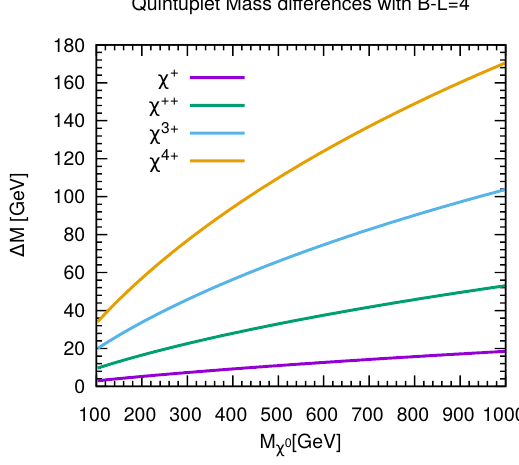
Figure 1 . Mass di(cid:11)erence between various charged states as a function of the neutral state’s mass for ( B L ) = 4 case, assuming M W (cid:0)